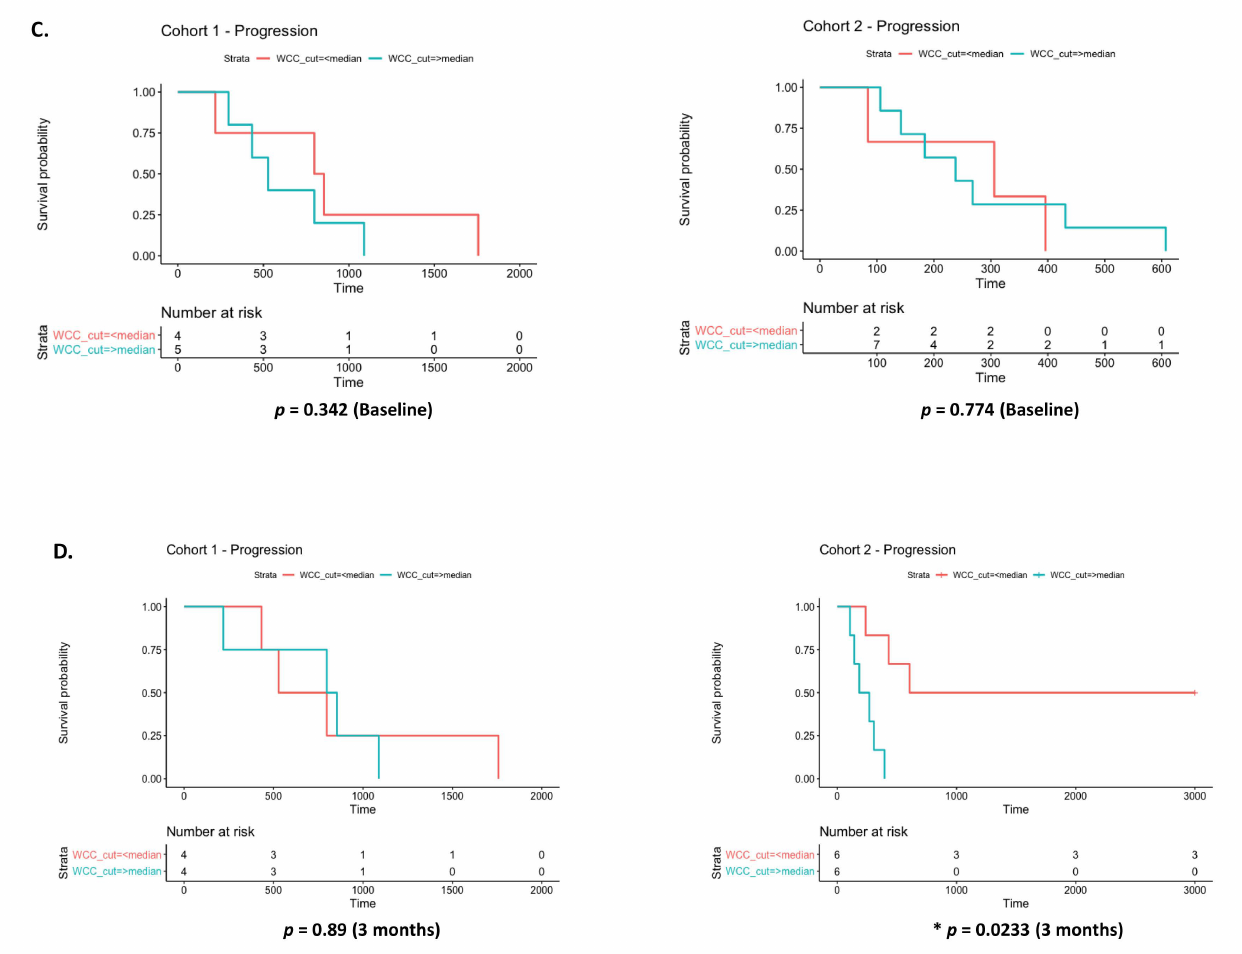
Figure 9. Prognostic significance of WCC in different cohorts. Automated white cell counts were recorded for EGFR patients. Combined cohorts in addition to each cohort alone were examined at baseline and at 3 months for the prognostic significance of white cell counts at baseline and at 3 months, using median cut-off values of ≥ 9.29 and ≥ 6.11, respectively. Combined WCC at baseline ( A ) and at 3 months ( B ), had no prognostic significance on time to progression or overall survival. When stratified into respective cohorts (1 and 2), patients in cohort 2 with high WCC had a significantly shorter time to disease progression ( C , D ). Univariate Cox proportional hazards analysis of time to progression was used and Kaplan Meier survival plots represented (* p <